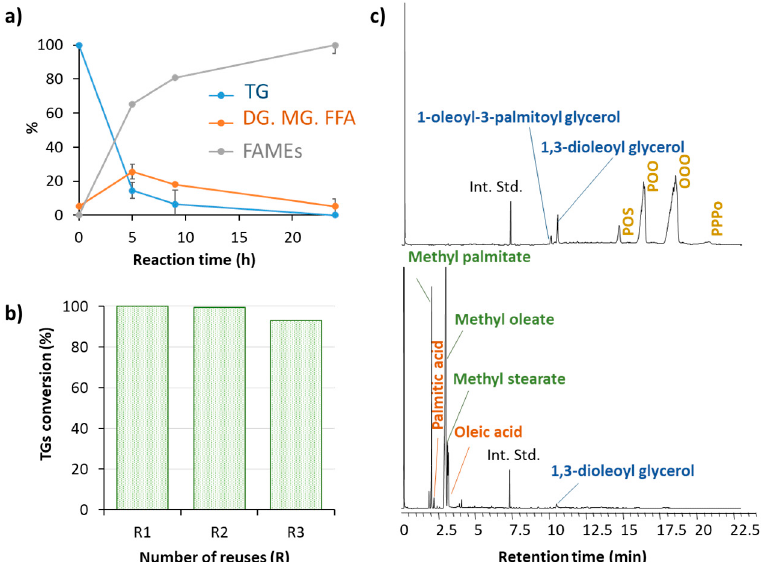
Figure 6. ( a ) Enzymatic transesterification of 25 mL of discarded cooking oil and methanol (25 °C, 100 rpm, oil:methanol 1:4, 5 g AMNP-CH-OPEr); ( b ) recyclability of AMNP-CH-OPEr in reactions of 24 h; ( c ) chromatograms of the reaction mixture at 0 h (upper graph) and 24 h (lower graph). OOO: Triolein; OOP: Palmitodiolein; POS: 1-palmitoyl, 2-oleyl, 3-stearoyl glycerol; PPPo: Palmitoleyldipalmitin.